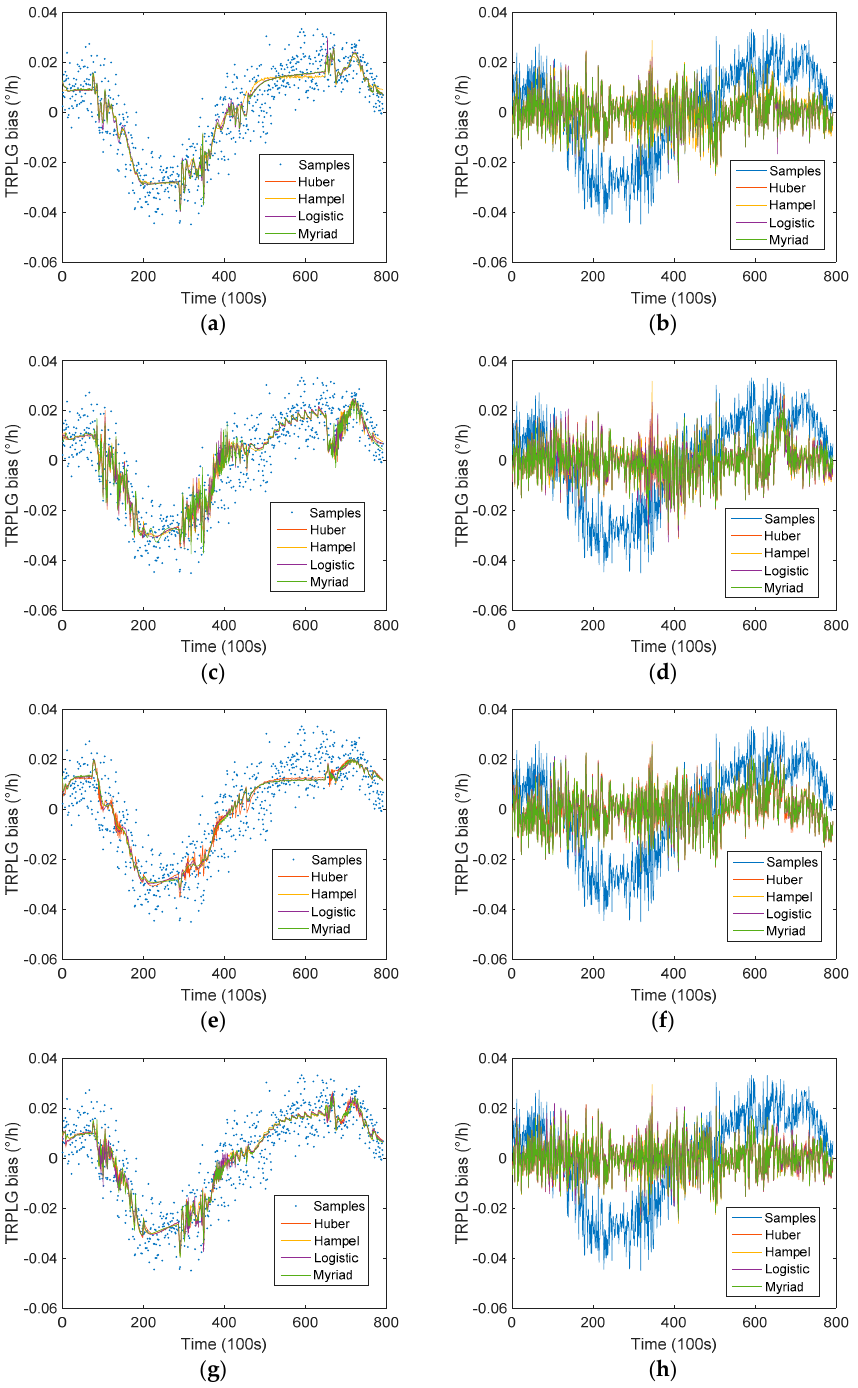
Figure 10. TRPLG bias compensation using different weight functions and composite parameters based on IR-LSSVM model: ( a ) Regression based on temperature and slope of temperature variation; ( b ) Compensation based on temperature and slope of temperature variation; ( c ) Regression based on temperature and UHFO; ( d ) Compensation based on temperature and UHFO; ( e ) Regression based on slope of temperature variation and UHFO; ( f ) Compensation based on slope of temperature variation and UHFO; ( g ) Regression based on all parameters; ( h ) Compensation regression based on all